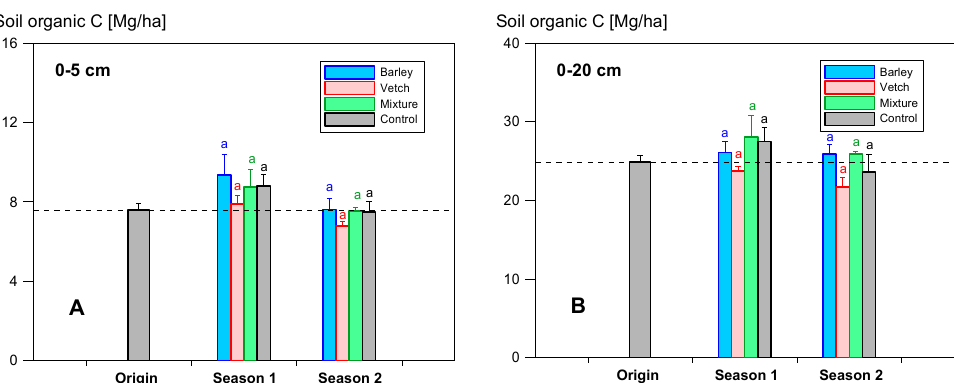
Figure 7. Soil organic carbon at the beginning and the end of the experiment during the study period at 0–5 cm ( A ) and 0–20 cm soil depth ( B ). Vertical bars represent standard error. Different letters in each season are statically different based on the LSD test ( p ≤ 0.05). X units follows the format DD-MM-YY.